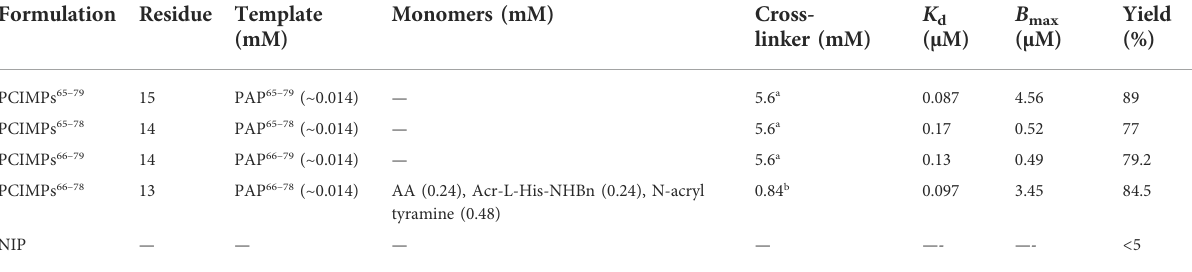
TABLE 2 Optimization of the formation of PCIMPs and af fi nity values toward PAP. Formulation Residue Template